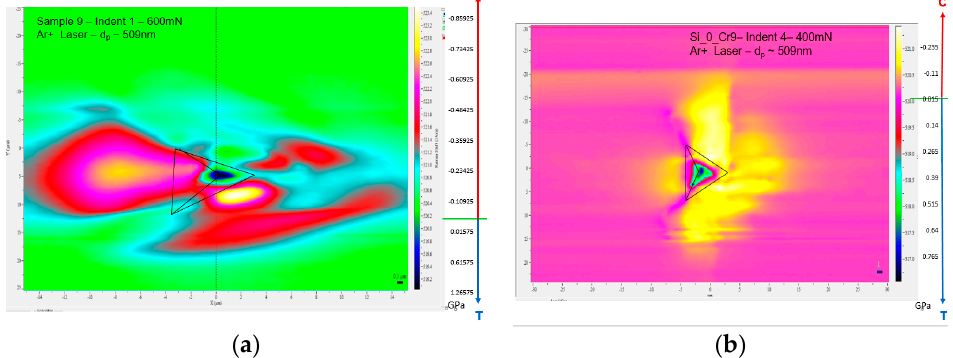
Figure 3. Two-dimensional maps of the stress as a function of position around: ( a ) a 600 mN; and ( b ) a 400 mN indent measured by micro-Raman spectroscopy profiling. The Raman spectroscopy map covers a region whose extent is 30 μ m (X) by 50 μ m (Y). Step size 0.5 μ m. The red and blue arrows indicate whether the stress is compressive (C) or tensile (T). The highest compressive stress is indicated by the yellow regions, while the greatest tensile strain is indicated by the black/blue regions. (Figure 3a is reproduced from ref. [9]) The Raman figures and the stress figures do not correspond directly. These scans took approximately 40 h to complete so the stress figures were calculated by compensating for environmental drift using the plasma